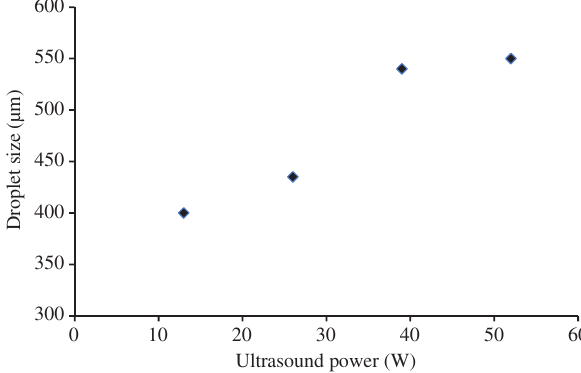
Figure 6: Effect of power of atomization on droplet size (flow rate = 2 ml/min, precursor concentration = 0.1